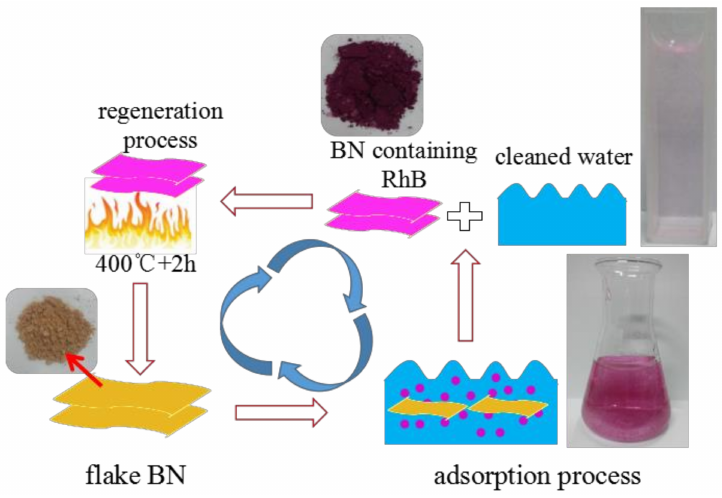
Figure 5. The schematic of adsorption and regeneration